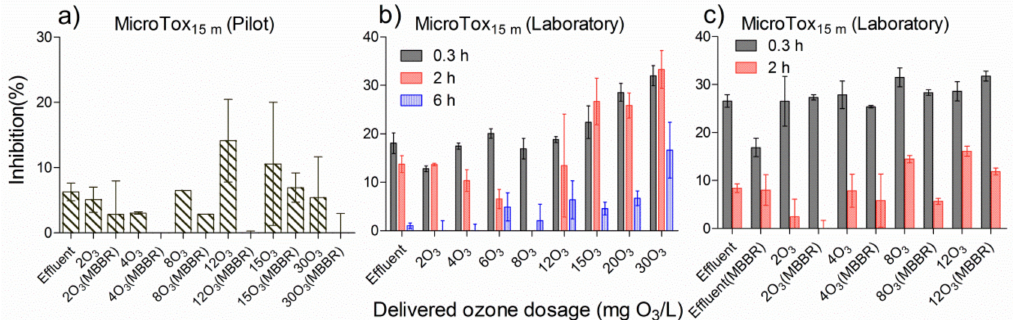
Figure 6. Comparison of MicroTox ® with a 15 min assay time under di ff erent ozone dosages in pilot and laboratory, followed by relevant MBBR polishing in pilot and laboratory over time. ( a ) e ffl uent treated by onsite continuous pilot-scale ozone at various doses and a subsequent pilot MBBR polishing tank, ( b ) e ffl uent treated by eight doses of ozone in the laboratory, ( c ) e ffl uent treated by a single polishing MBBR, four doses of ozone in the laboratory, with or without subsequent MBBR